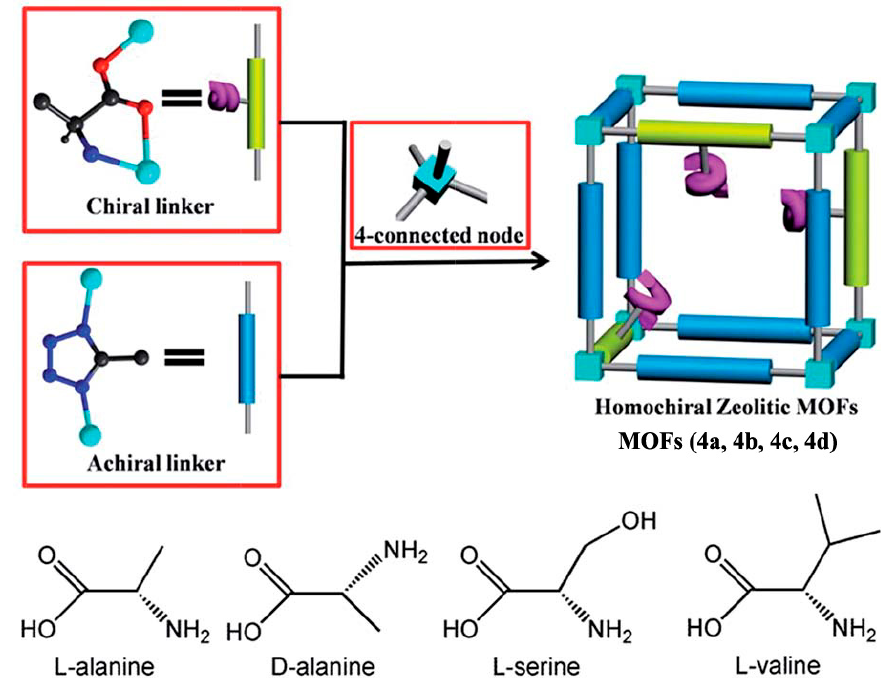
Figure 4. The synthetic strategies of homochiral zeolitic MOFs 4a , 4b , 4c , and 4d . Reproduced from [56] with permission from the Royal Society of Chemistry.